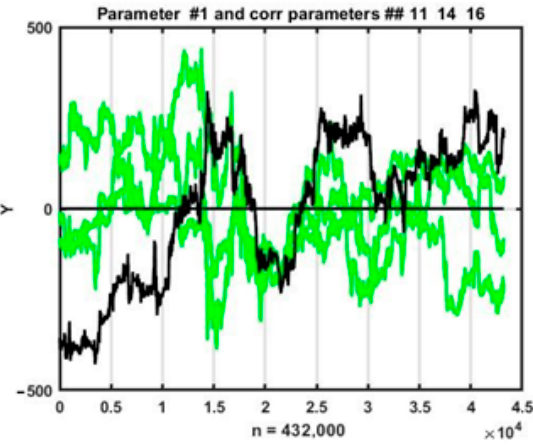
Figure 1. A tonal representation of the 16-parameter chaotic flux correlation matrix.